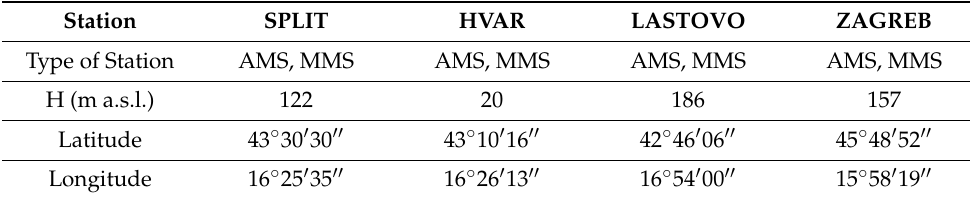
Table 1. Characteristics of four investigated meteorological